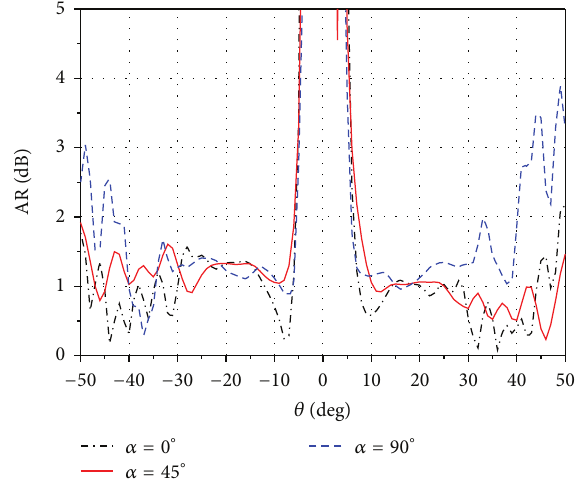
Figure 14: The AR of OAM state ℓ = +3 for left circular